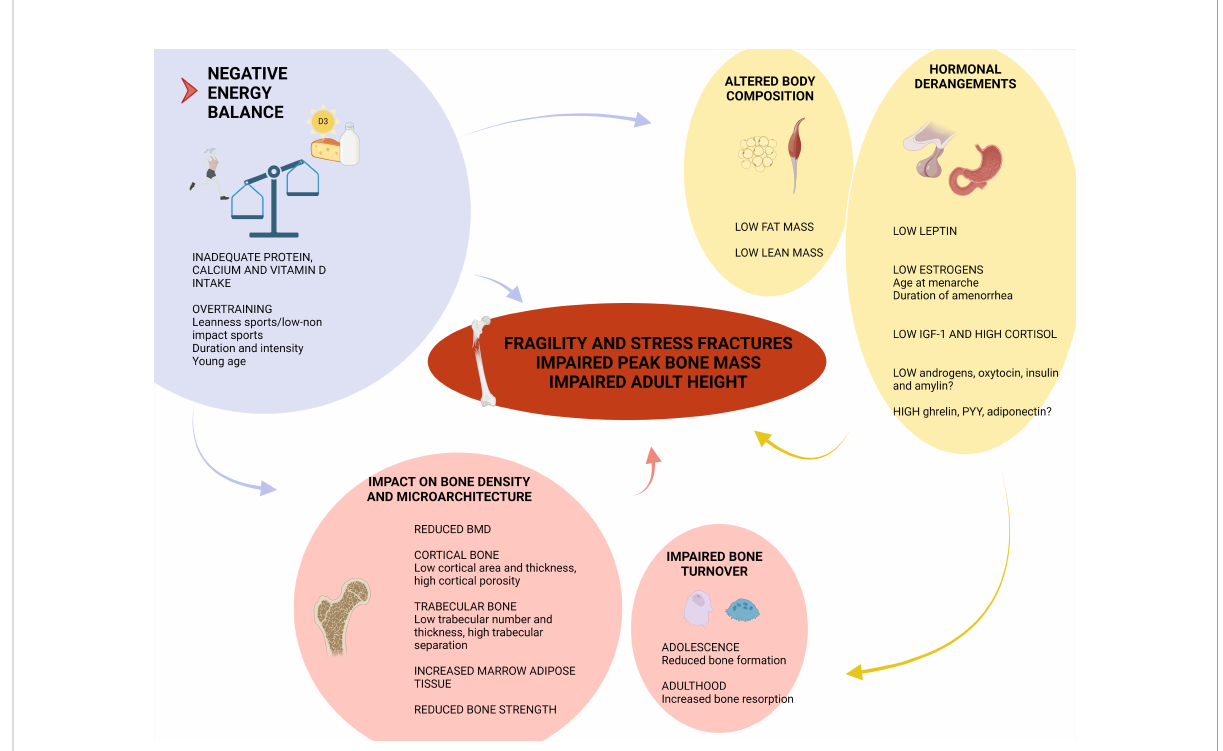
FIGURE 1 Determinants of skeletal fragility in functional hypothalamic amenorrhea (FHA). Negative energy balance is the prime determinant in FHA physiopathology. Not only the caloric intake, but also the insuf fi cient amount of dietary calcium, vitamin D and proteins impact on bone. In